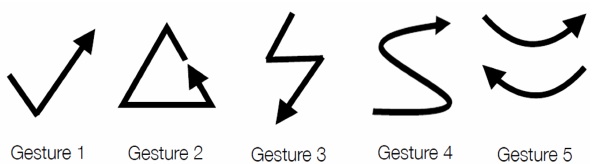
Figure 5. The five foreground gesture classes considered in both training and testing sets.